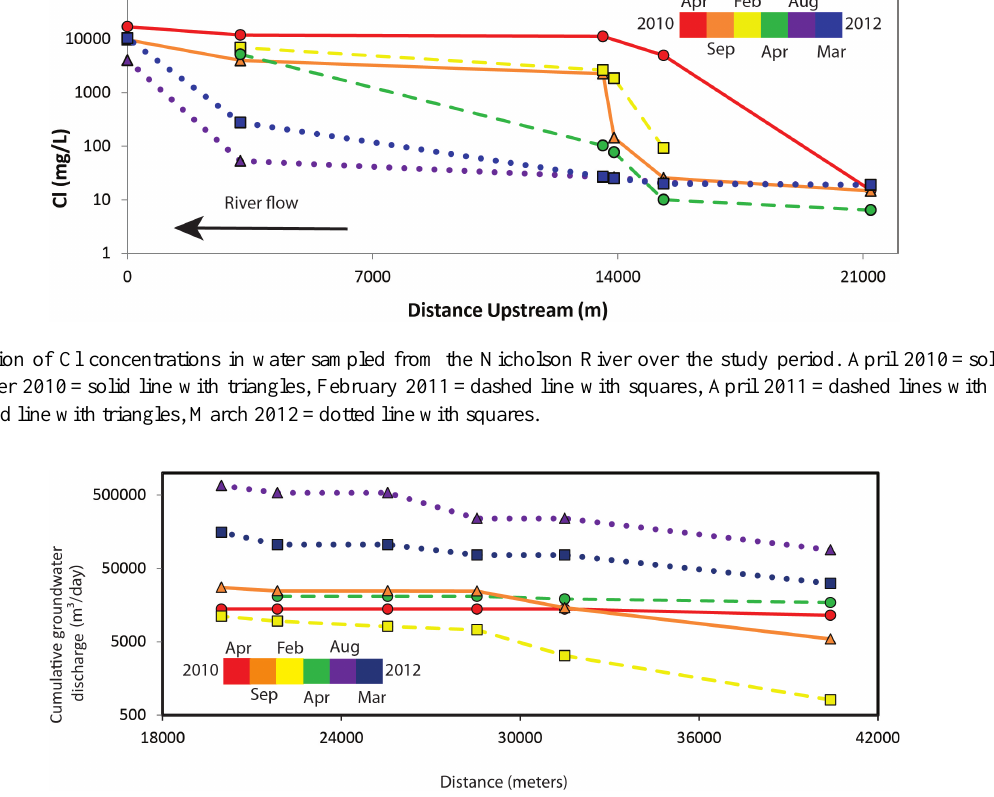
Fig. 8. Cumulative groundwater discharge to the Tambo River from 222 Rn mass balance. April 2010=solid line with circles, Septem- ber 2010=solid line with triangles, February 2011=dashed line with squares, April 2011=dashed lines with circles, August 2011=dotted line with triangles, March 2012=dotted line with